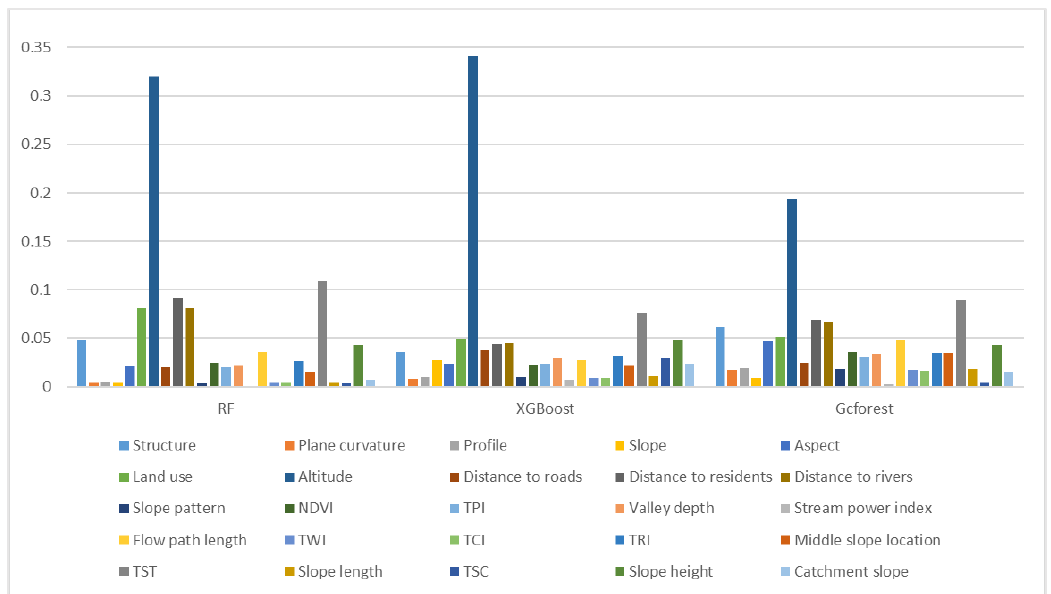
Figure 8. Feature importance measures (FIMs) for the factors that influence landslides in different models .